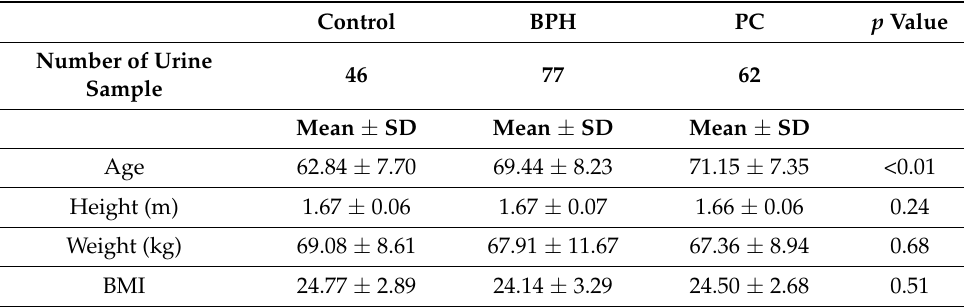
Table 1. Demographic and clinical data of research